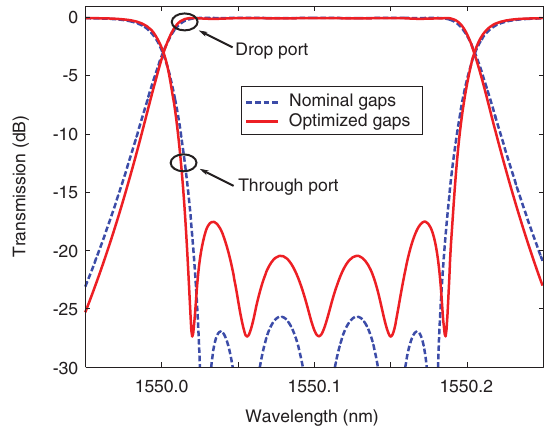
Figure 6: Transfer functions of unoptimized nominal design and optimized design at the through ports and drop ports in case